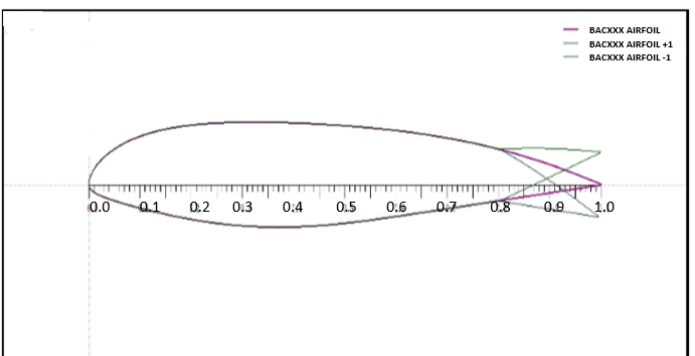
Figure 10. Airfoil modeled in XFLR—the three setups for trailing edge flap